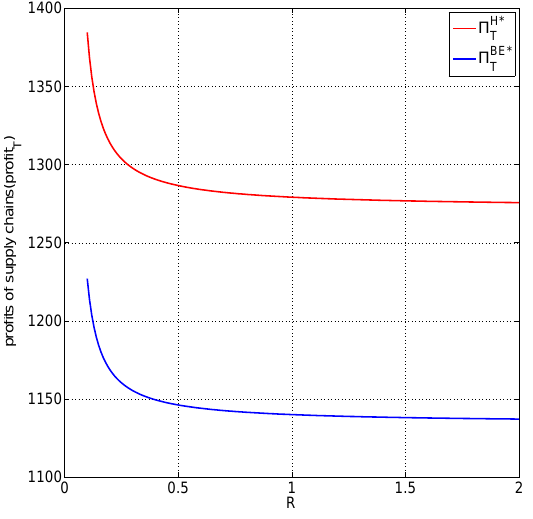
Figure 18. The influences of R on the total supply chain’s profit Π T